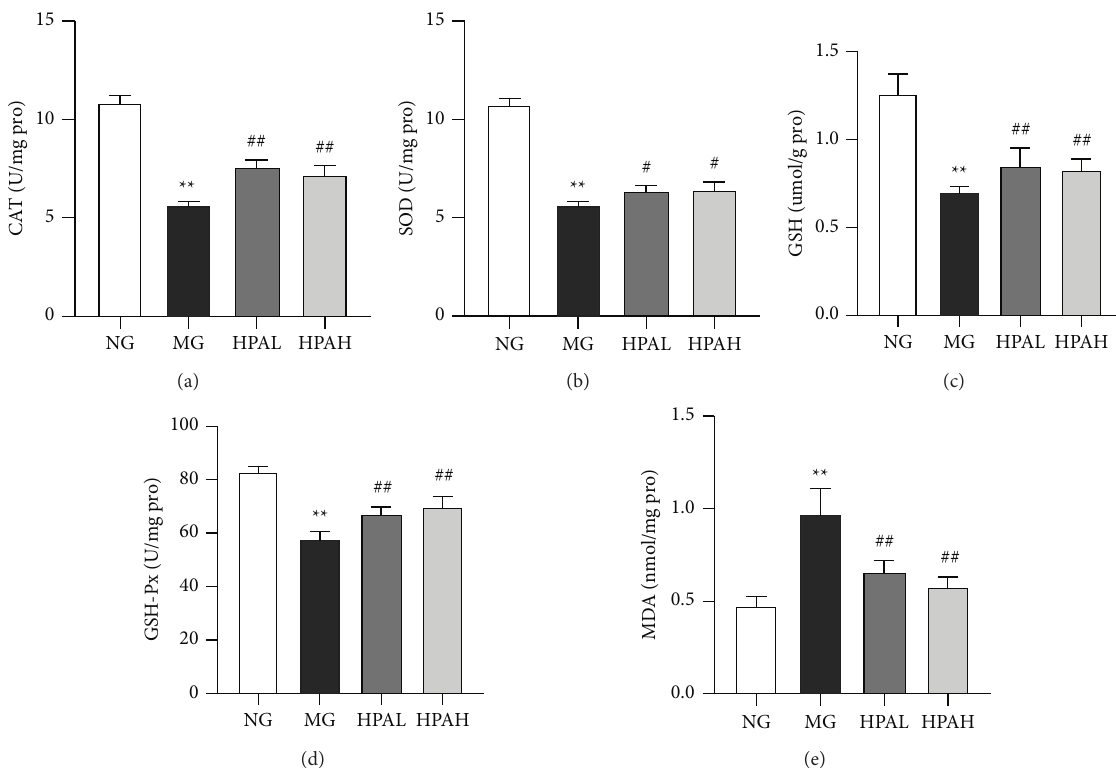
Figure 3: Effect of HPA on the antioxidant capacities in ALD mice. (a) CATactivity; (b) SOD activity; (c) GSH activity; (d) GSH-Px activity; (e) MDA level. Data were expressed as mean ± SD ( n � 12). ∗∗ p < 0 . 01, versus NG; # p < 0 . 05 and ## p < 0 . 01, versus MG.